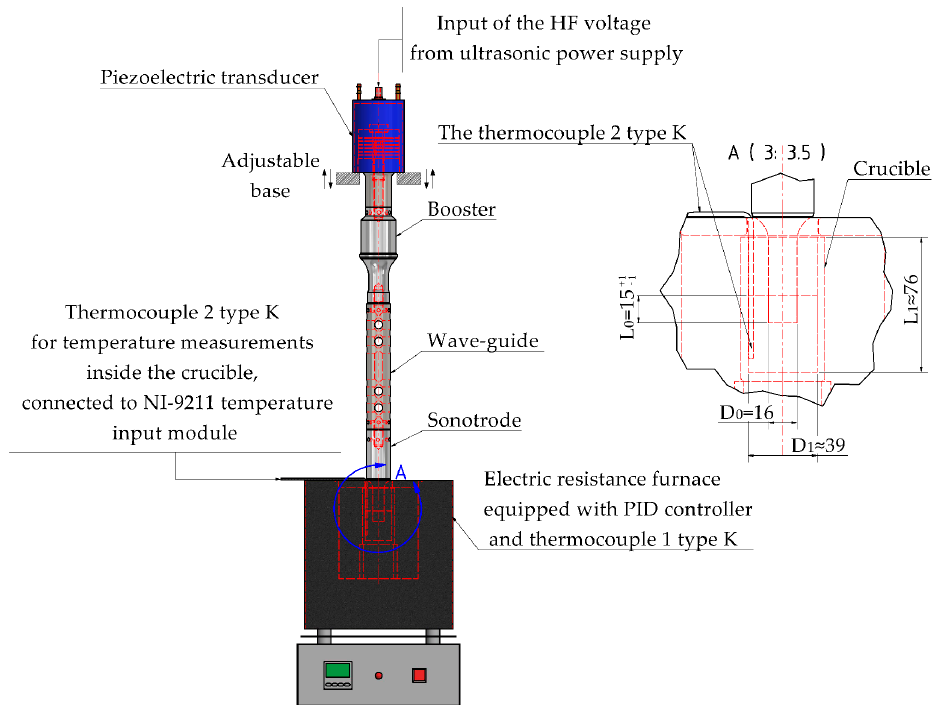
Figure 1. Schematic diagram of the ultrasonic vibration (USV) process showing the mechanical parts of the ultrasonic system, crucible dimensions ( D 1 and L 1 ), the sonotrode tip diameter D 0 , the immersing distance D 0 of the sonotrode inside the melt, and the additional thermocouple 2 and its location for monitoring the melt temperature. All dimensions are by mm. Table 1. Composition of the pure elements in wt.%.